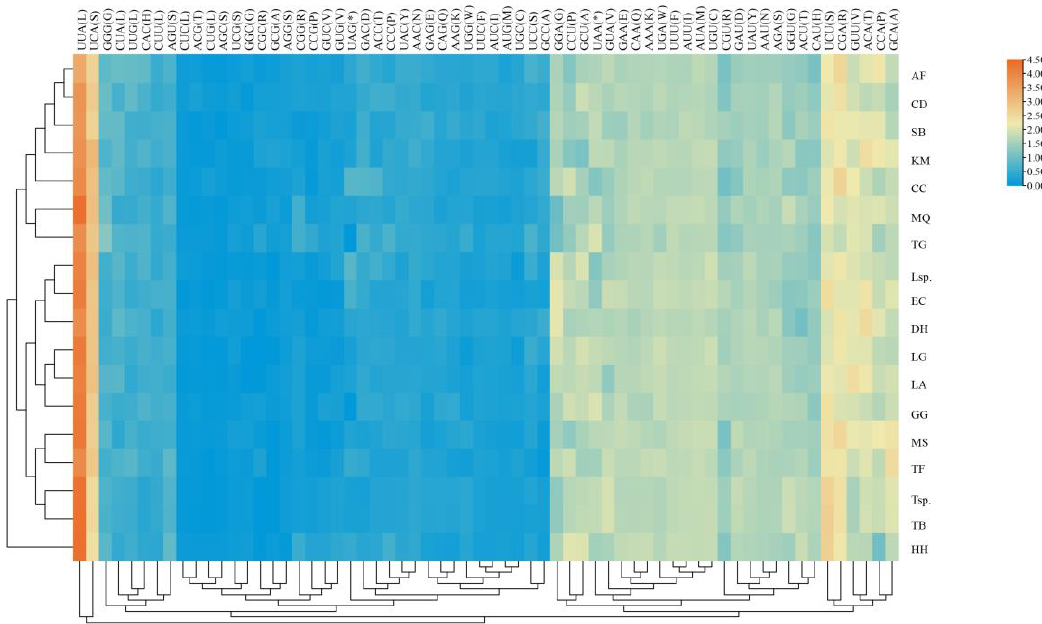
Figure 3. The relative synonymous codon usage (RSCU) of PCGs in the 18 treehoppers mitogenomes. The x -axis and y -axis indicate the hierarchical clustering of codon frequencies and treehoppers species, respectively. AF: Antialcidas floripennae , CD: Centrotoscelus davidi , SB: Stictocephala bisonia , KM: Kotogargara minuta , CC: Centrotus cornutus , MQ: Maurya qinlingensis , TG: Tricentrus gammamaculatus , Lsp.: Leptobelus sp. EC: Entylia carinata , DH: Darthula hardwickii , LG: Leptobelus gazella , LA: Leptocentrus albolineatus GG: Gargara genistae , MS: Machaerotypus stigmosus , TF: Tricentrus fulgidus , Tsp.: Tricentrus sp., TB: Tricentrus brunneus , HH: Hypsauchenia hardwickii